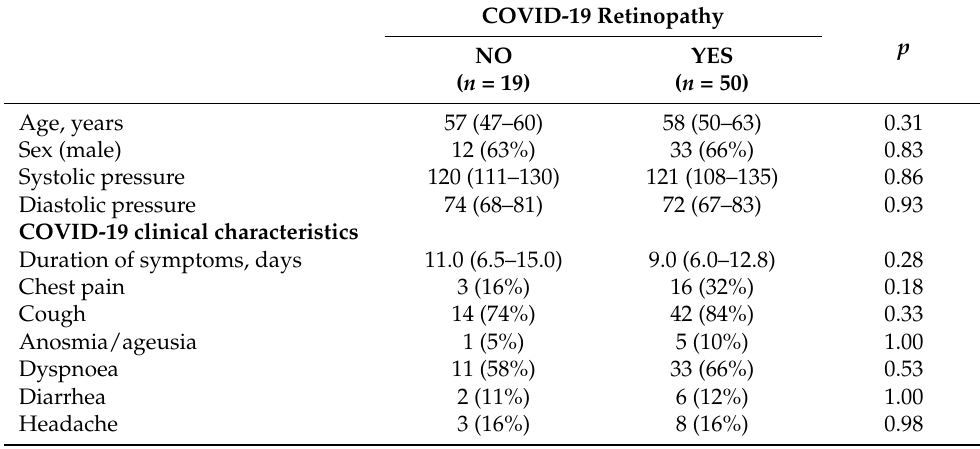
Table 2. Baseline characteristics based on the presence of COVID-19